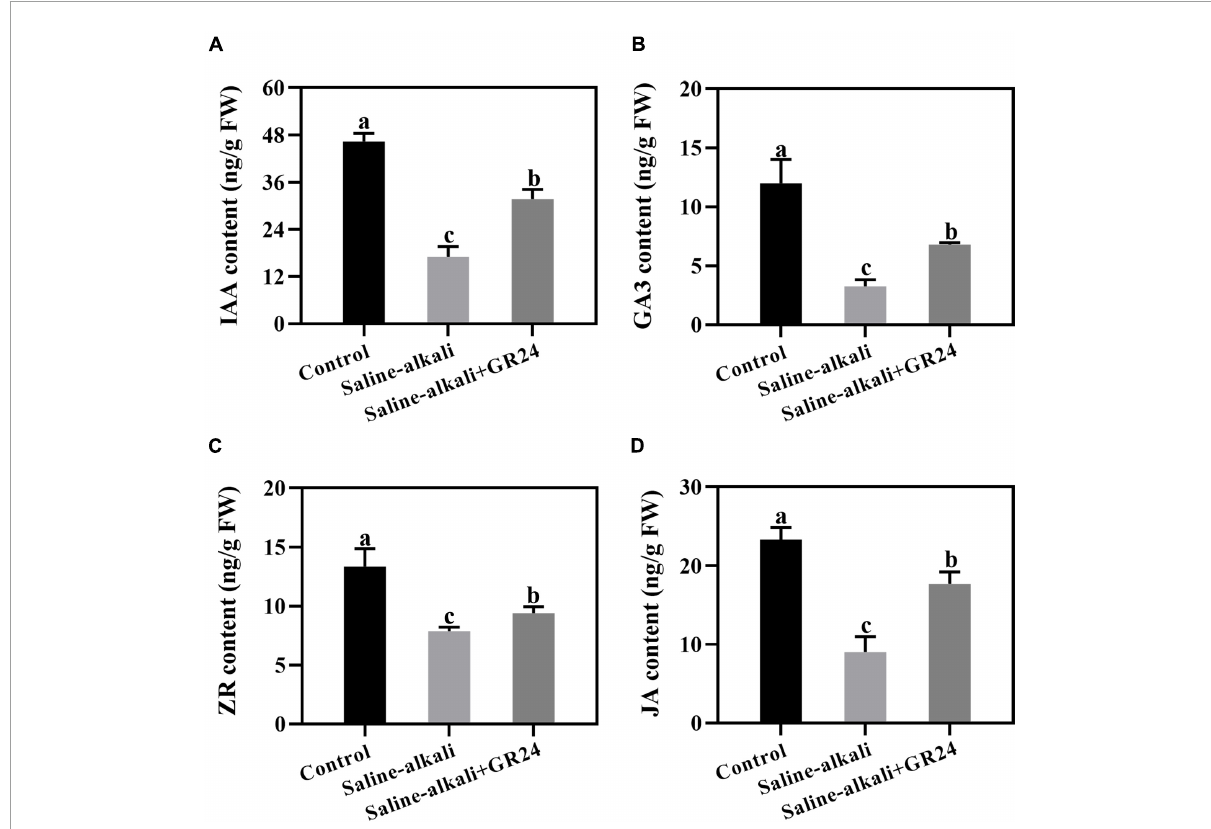
FIGURE6 Effects of GR24 treatment on the contents of auixn (A) , glbberellin (B) , cytokinin (C) and jasmonic acid (D) under salinity-alkalinity stress. The data represent the mean ± SD of three biological replicates. Different lowercase letters indicate significant differences according to Fisher’s least significant difference ( P <